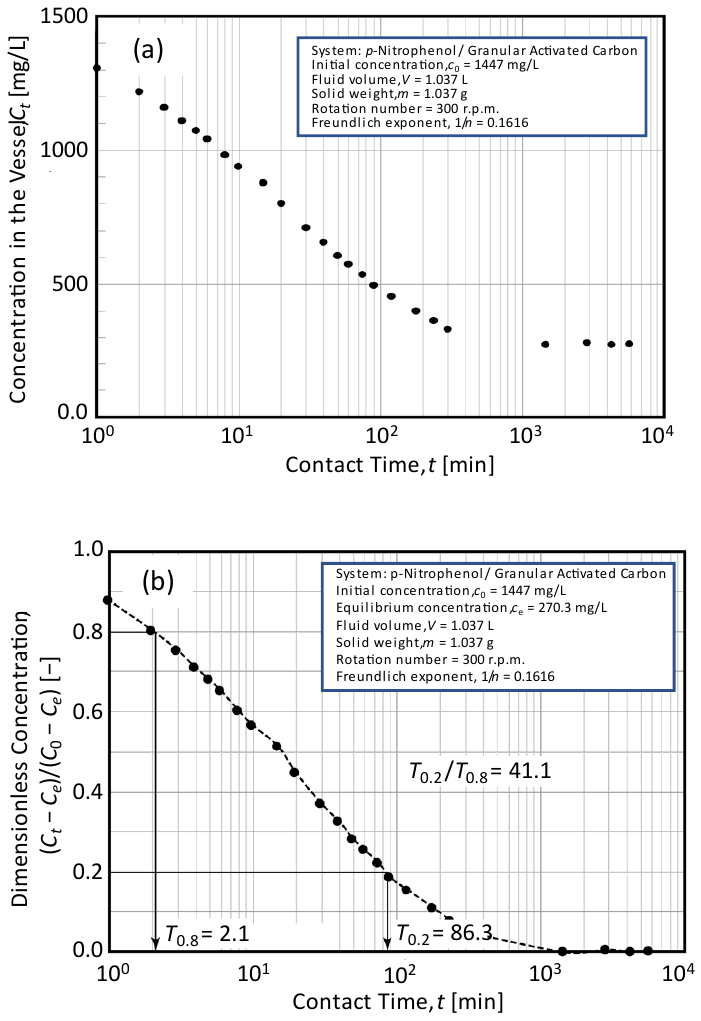
Figure 6. Experimental concentration decay curve. ( a ) Dimensional decay curve, ( b ) dimensionless decay curve.